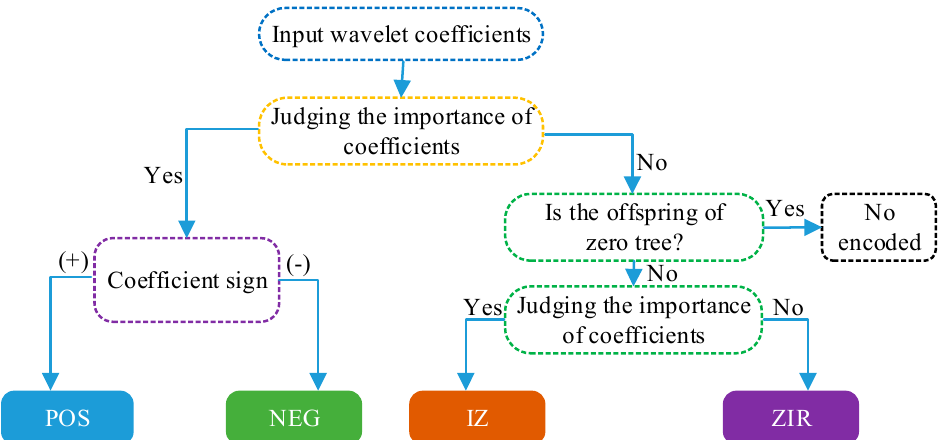
Figure 10. The encoding process of Embedded Zerotree Wavelets (EZW) algorithm.